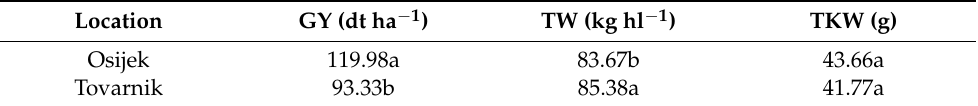
Table 2. Grain yield and agronomical components at different